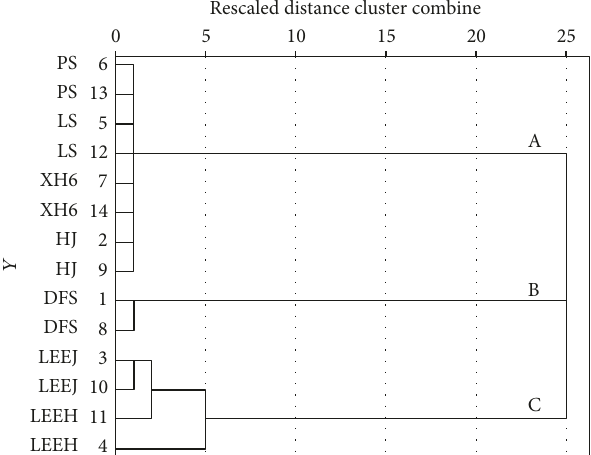
Figure 3: Dendrogram from the hierarchical cluster analysis using centroid clustering of seven SFFPs samples with the relative abun- dances of 96 volatile compounds as variables. The different clusters are marked as A, B, and C. 𝑥 -axis means rescaled distance cluster; 𝑦 -axis means the samples measured.